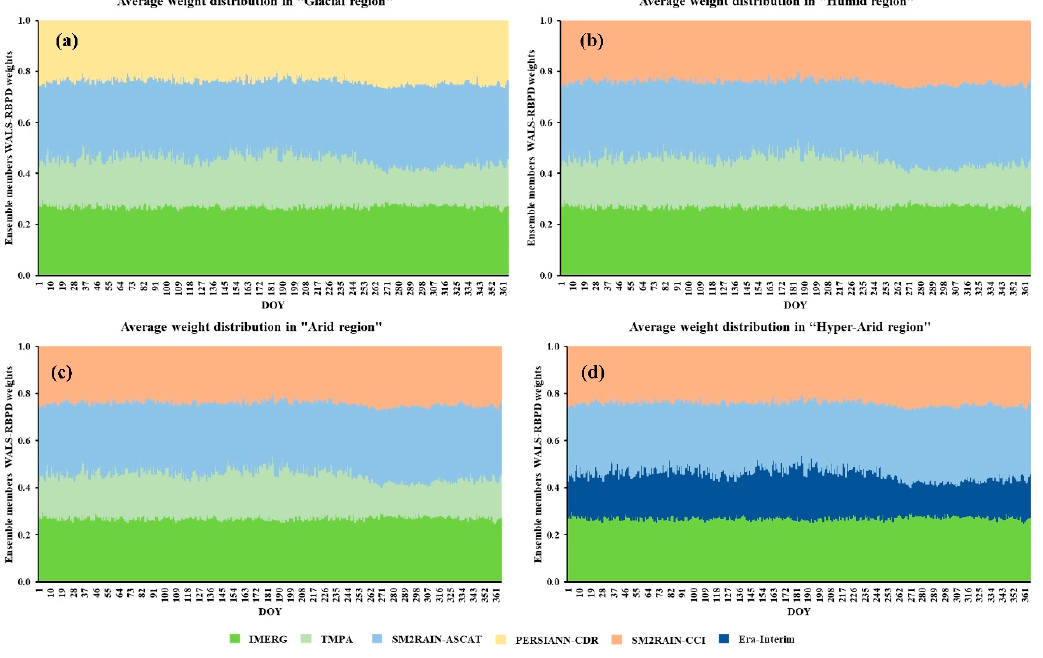
Figure 8. Temporal distribution of WALS-RBPD weights against the day of the year (DOY) across the regions. ( a ) Glacial; ( b ) Humid; ( c ) Arid; ( d ) Hyper-arid. Remote Sens. 2020 , 12 , x FOR PEER REVIEW